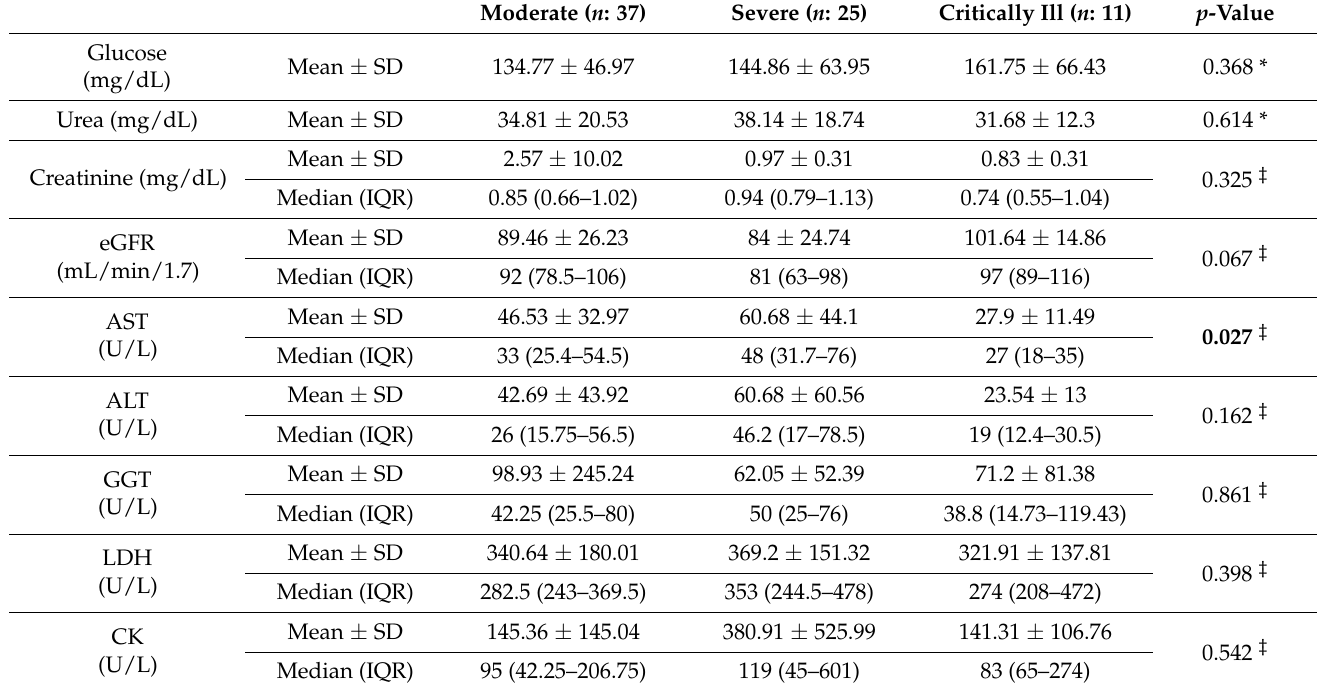
Table 2. Laboratory findings of COVID-19 patients in the moderate, severe, and critical groups on admission to the